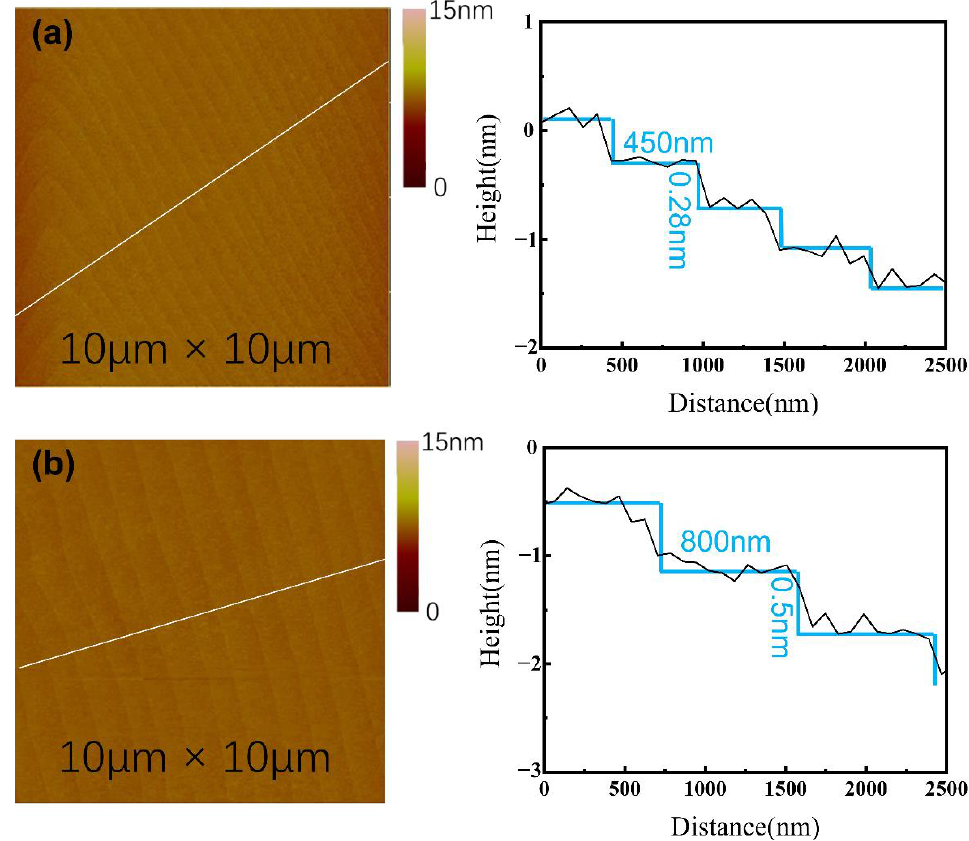
Figure 3. AFM images and profile figures of surfaces with two different step widths at a T g of 1650 °C. ( a ) on top of the hexagonal table, ( b ) on top of the LMR.